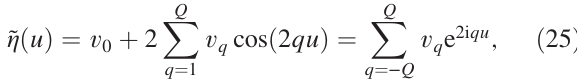
FIG. 3. Tune map for horizontal linear chromaticity. The borders of the neck-tie island are shown as colored edges of the plot, corresponding to the lines in Fig.